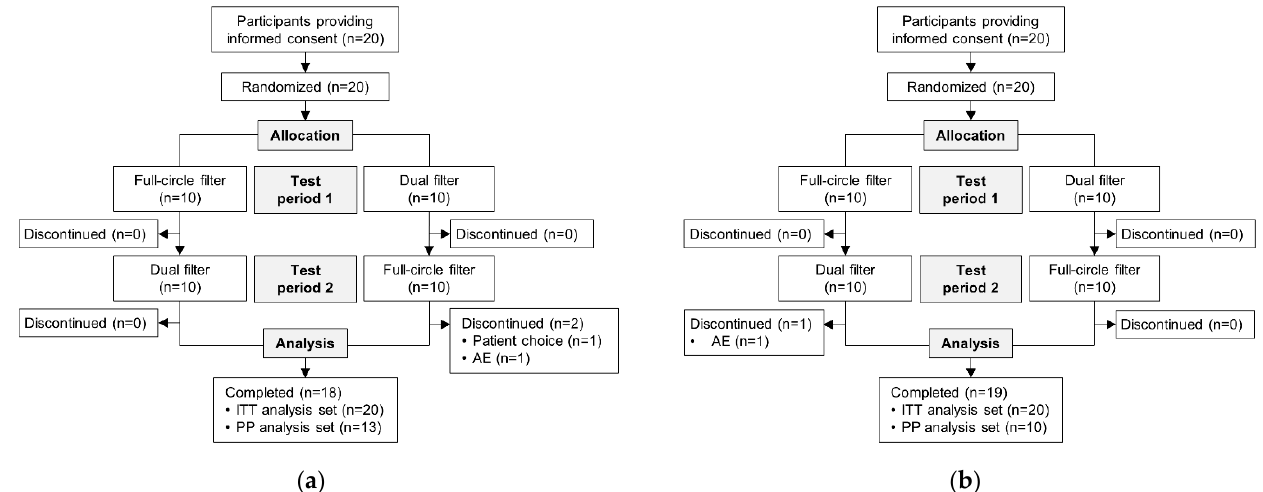
Figure 3. Participant disposition for ( a ) participants with a colostomy, and ( b ) participants with an ileostomy. AE = adverse event; ITT = intention-to-treat; PP = per-protocol. Baseline demographics and clinical characteristics are presented in Table 1. At base- line, 21.1% (n = 4) of participants with a colostomy and 52.6% (n = 10) of participants with